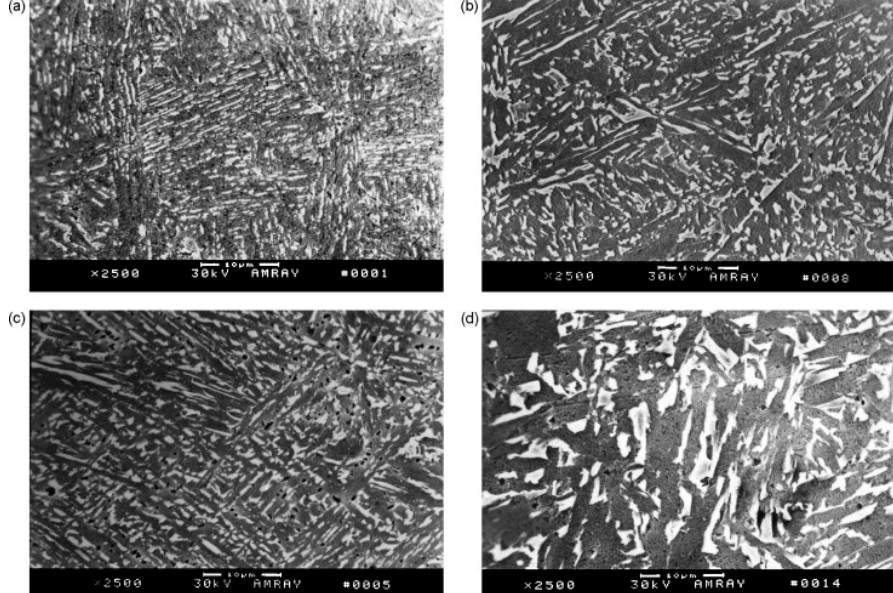
Figure 5. Morphological variation of M/A constituent with different cooling times: ( a ) 18 s, ( b ) 45 s, ( c ) 100 s, and ( d ) 240 s. Reprinted with permission from ref. [43]. Copyright 2008, Elsevier.